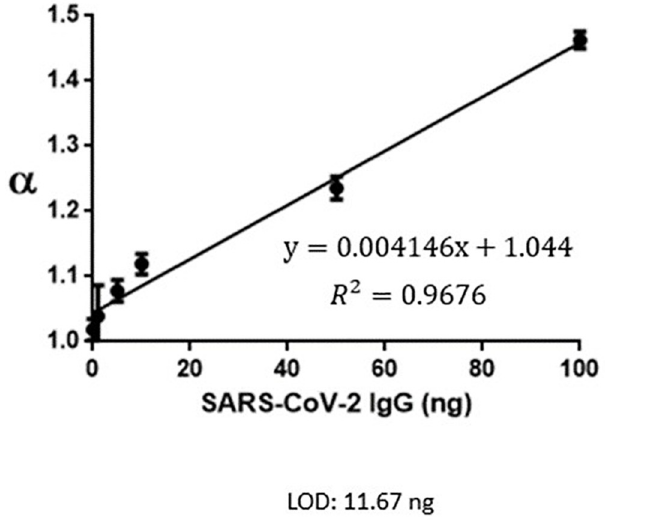
Fig 1. SARS-CoV-2 IgG standard curve.